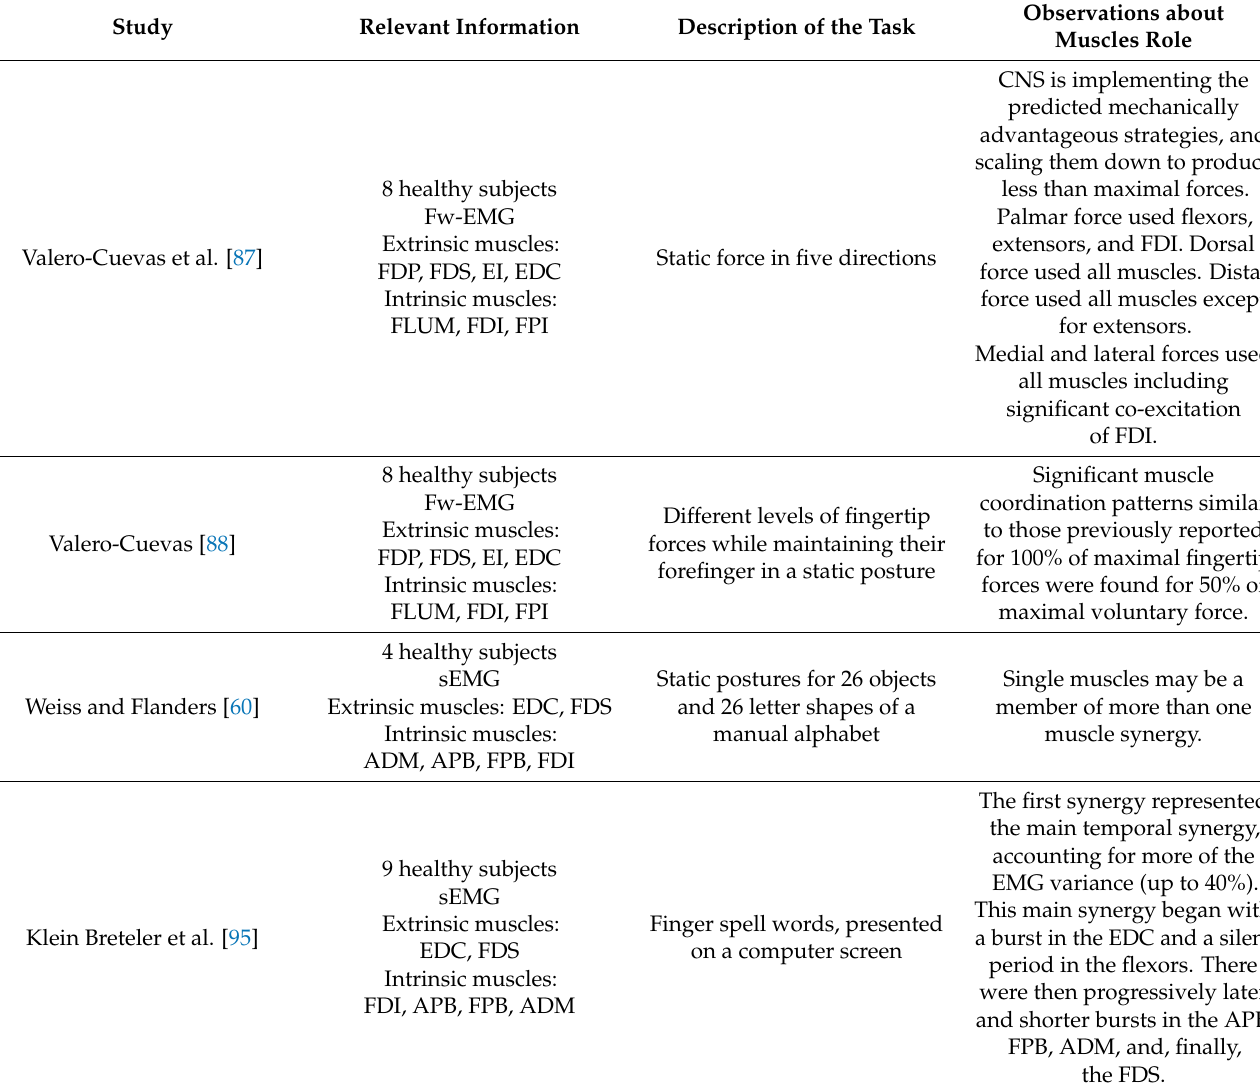
Table 2. Summary of the studies included in the systematic literature review (II). Relevant information contains subjects, type of EMG used, and muscles recorded in the